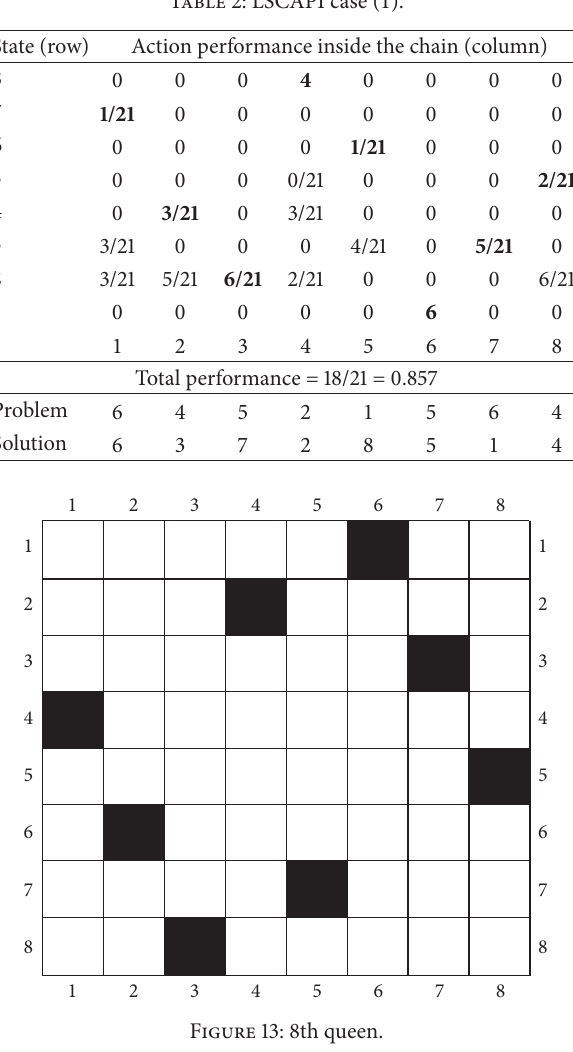
Table 2: LSCAPI case ( 1 ).